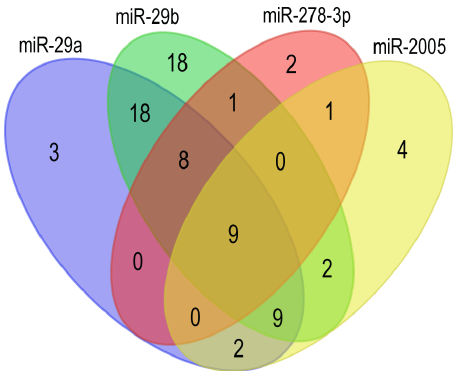
Figure 9. Venn diagram of the identified KEGG pathways.